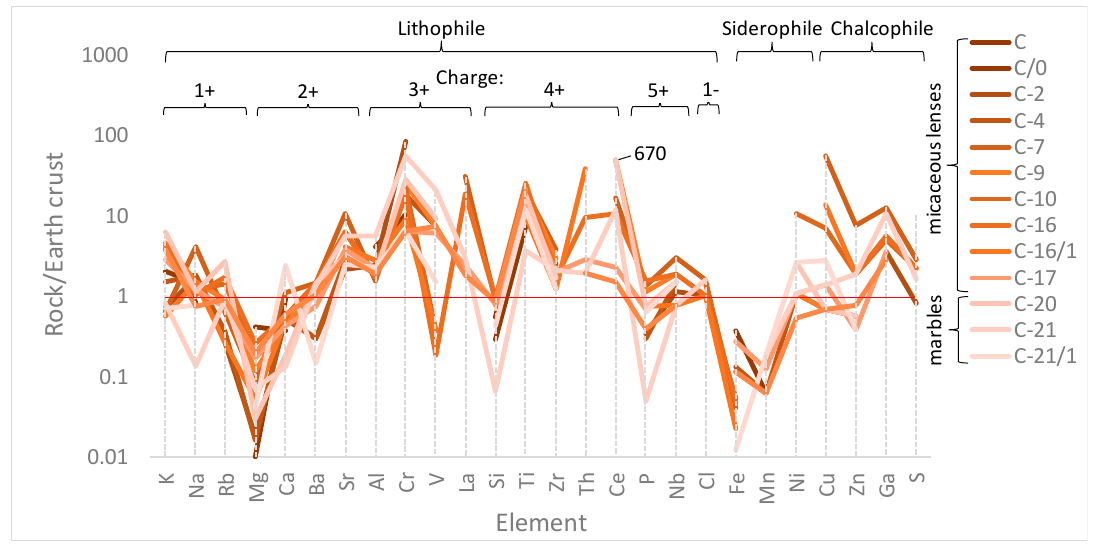
Figure 10. Crustal-normalized concentrations of lithophile (arranged by cation / anion charge), siderophile and chalcophile elements in the Snezhnoe deposit. The cerium ratio at 670 was cutoff. The values for the Earth’s crust are from [36].